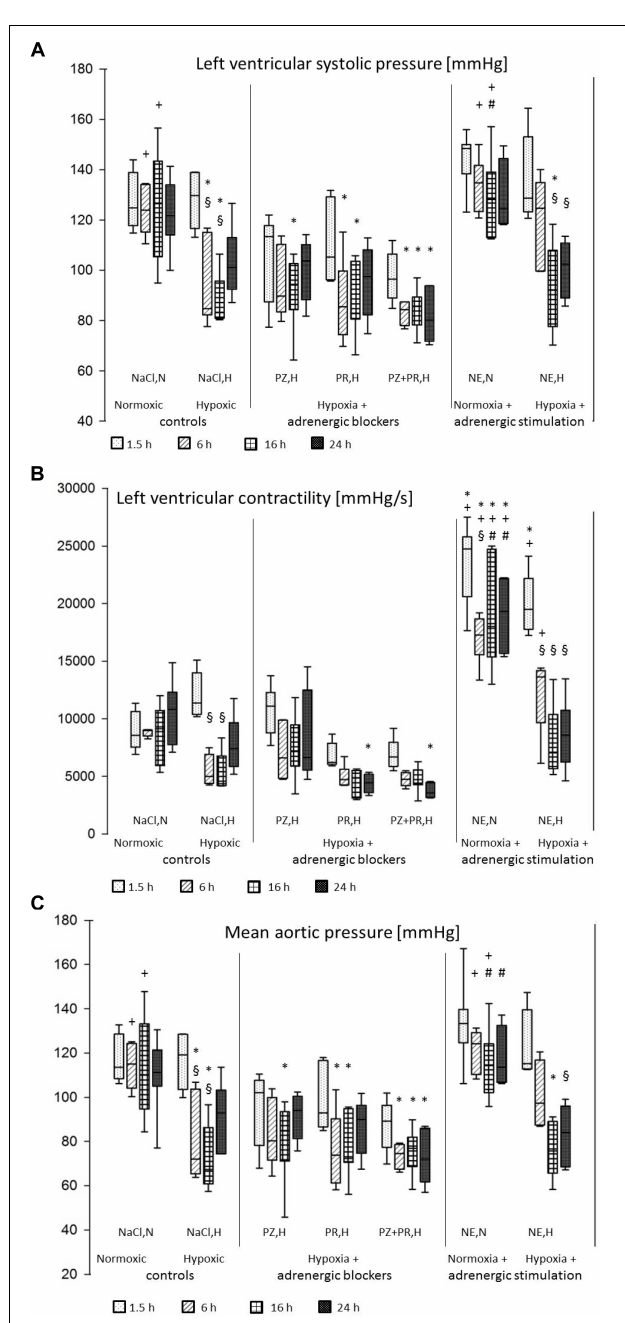
FIGURE 1 | (A) Left ventricular systolic pressure [mmHg]; (B) Left ventricular contractility (LV dP/dtmax) [mmHg/s]; (C) Mean aortic pressure [mmHg].